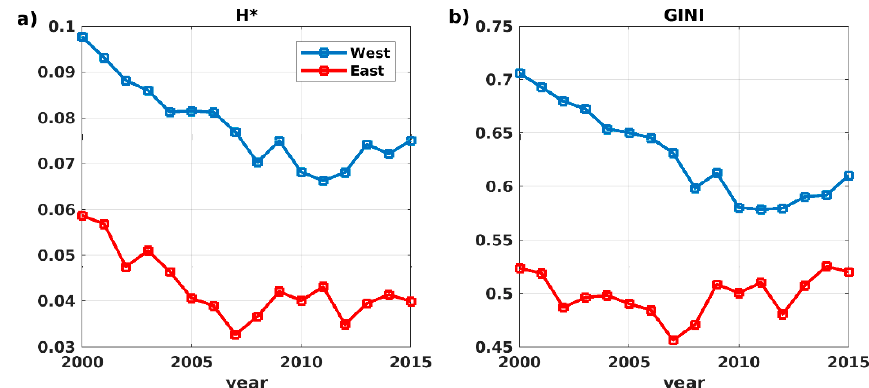
Figure 5. ( a ) Normalized Herfindahl-Hirschman index ( H* ) and ( b ) Gini coefficient for container ports in the Mediterranean, 2000–2015 for each region. Note that the scales do not cover the range of the indexes (i.e., 0–1).